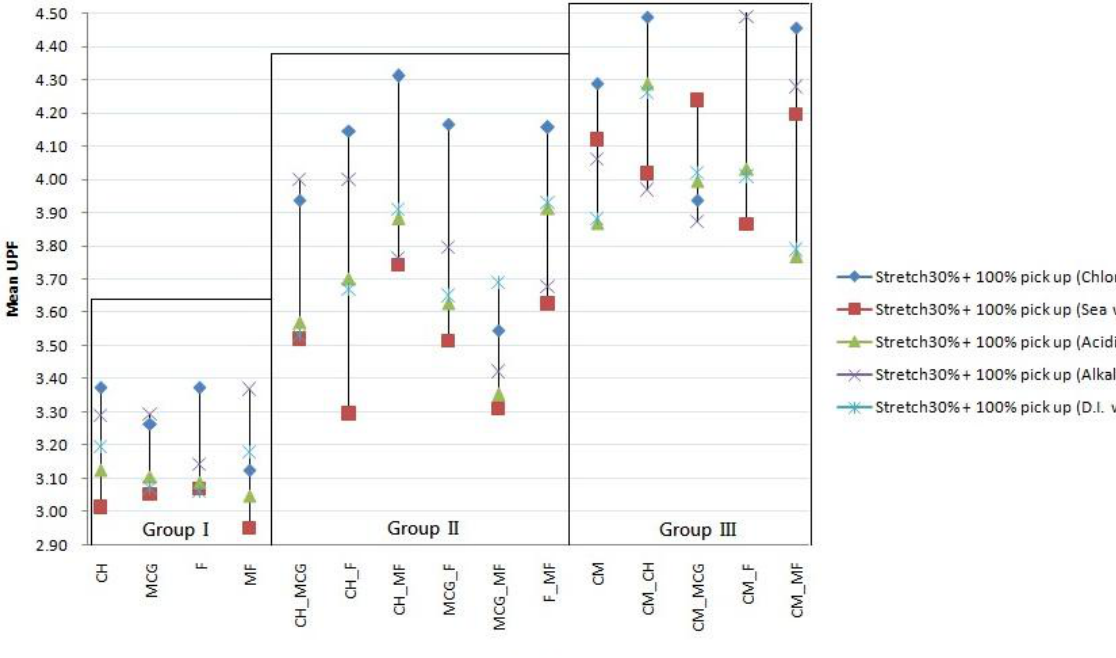
Figure 6. Overall performances of all samples subjected to 100% pick-up and 30%